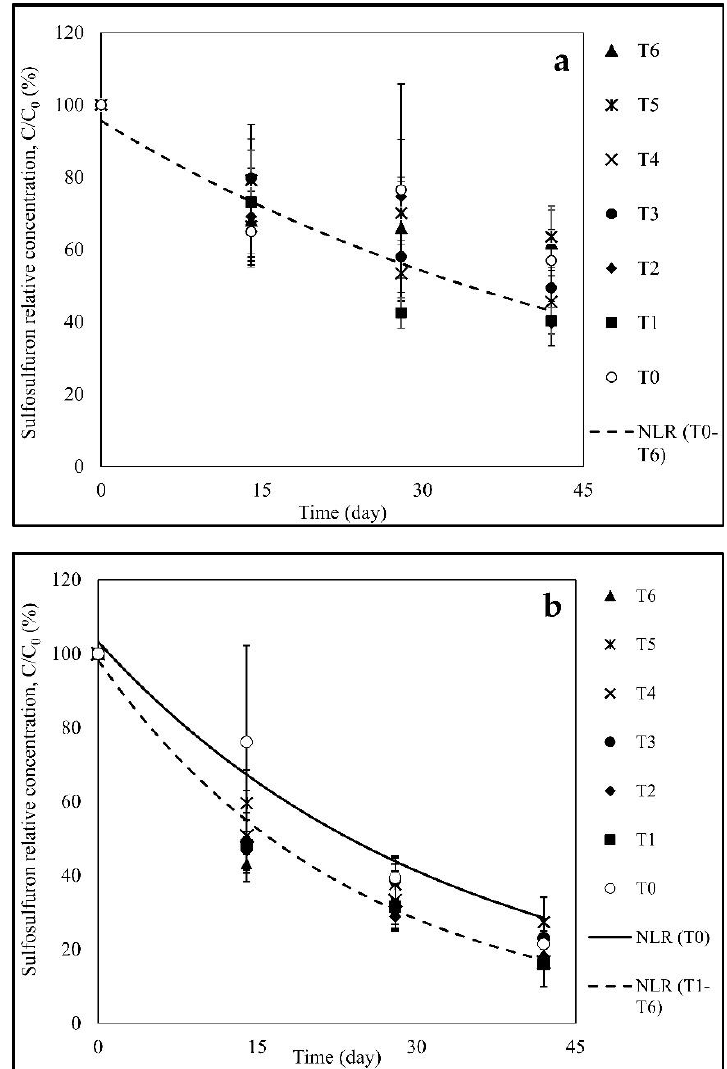
Figure 2. Degradation of sulfosulfuron in soil samples with different history of sulfonylurea application in a controlled environment ( a ) and in the field ( b ). Sulfosulfuron concentration ( C ) was quantified in soil extract using liquid chromatography–tandem mass spectrometry (LCMS-MS) and presented as a percentage of the initial measured concentration ( 𝐶 0 ). Details of SU application rate and timings are given in Table 2. An exponential decay non-linear regression (NLR) was fitted to the data of relative sulfosulfuron concentration, C/C 0 (Table S3 and Table S4 for controlled environment and field, respectively); treatment data are grouped in one regression analysis based on the F-test applied to each treatment versus the grouped data (Equation (3)). Error bars represent the standard error ( n = 5). NLR = Non-linear regression.